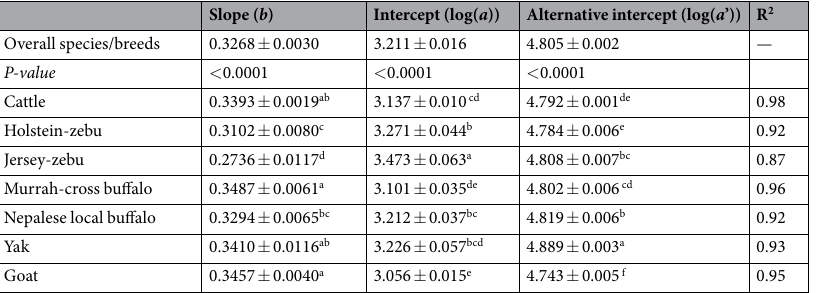
Table 2. Estimated allometric parameters (parameter estimate ± s.e.) for chest girth (CG) relative to body weight (BW). R 2 ; coefficient of determination. (a,b,c,d,e,f) Values in the same columns in the interspecies/ breeds comparison with different superscripts differ significantly ( P < 0.05). The slopes and intercepts were estimated from the equation log CG = log( a ) + b log BW . The alternative intercepts were estimated from the equation log CG = log( a’ ) + b (log BW + k ). The value k = − 4.8791 was used. P-value indicating whether or not the slope or intercept is affected by species or